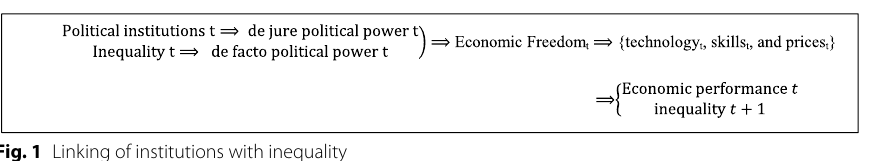
Fig. 1 Linking of institutions with